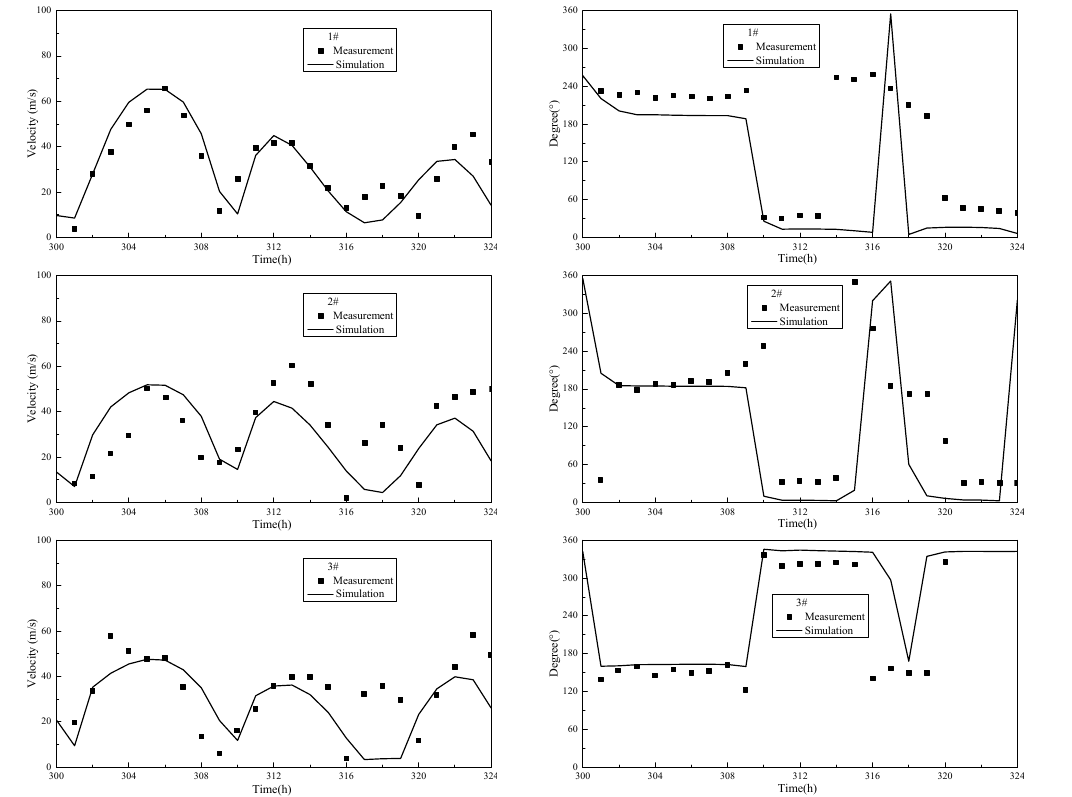
Figure 3. Comparisons of measured and calculated velocity and direction of neap tides.